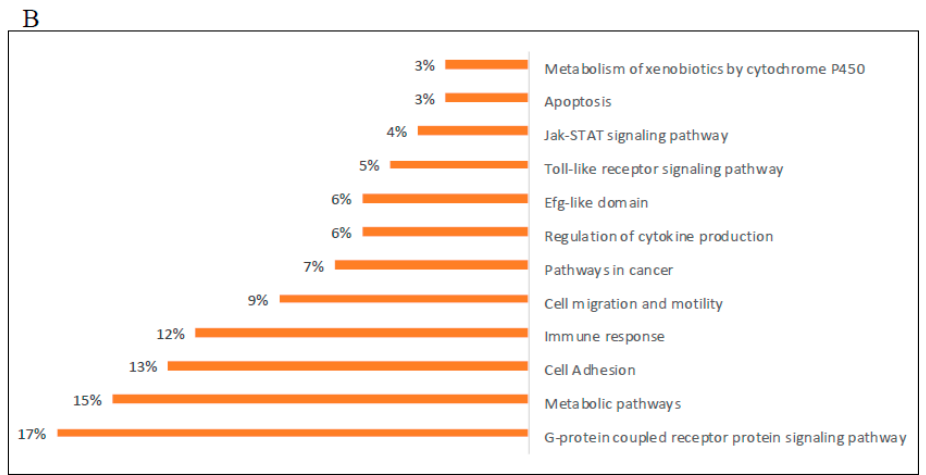
Figure 2. Genomic analysis of Laron Syndrome patients. ( A ) Hierarchical cluster analysis of differentially expressed genes in lymphoblastoids derived from four female LS patients and four controls of the same age range (LS, 44.25 ± 6.08 yr; controls, 51.75 ± 11.3 y) and ethnic (Yemen, Irak, Iran) origin. The figure depicts a cluster of 39 differentially expressed genes (FC > 2 or < than − 2 and p -value < 0.05). Up-regulated genes are shown in red and down-regulated genes are shown in blue. FC, fold change. This panel was obtained from [67]. ( B ) Functional analysis of differentially represented signaling pathways in LS. Bioinformatic analyses were conducted using the David and WebGestalt platforms. The % values in each category correspond to the percentage of the total number of differentially expressed genes.